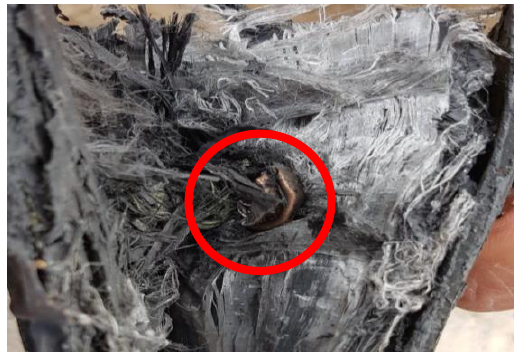
Fig.3: The ballistic test by handgun bullets of 9*19 mm from a distance of 4 m.